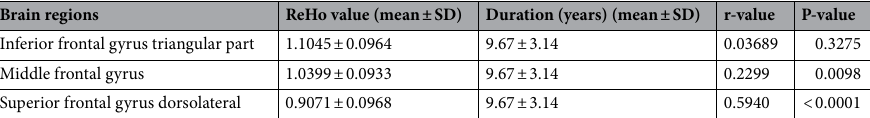
Table 3. Pearson correlations analysis. ReHo regional homogeneity, SD standard deviation.